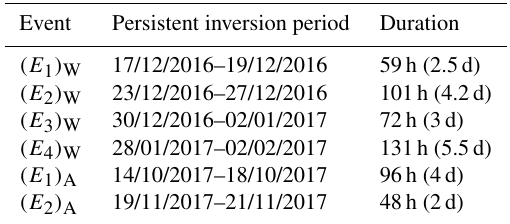
Table 3. Persistent temperature inversion events (E i ) by season (winter, W; spring, Sp; summer, S; autumn, A) detected by the radon-based method (RBM), including time period and